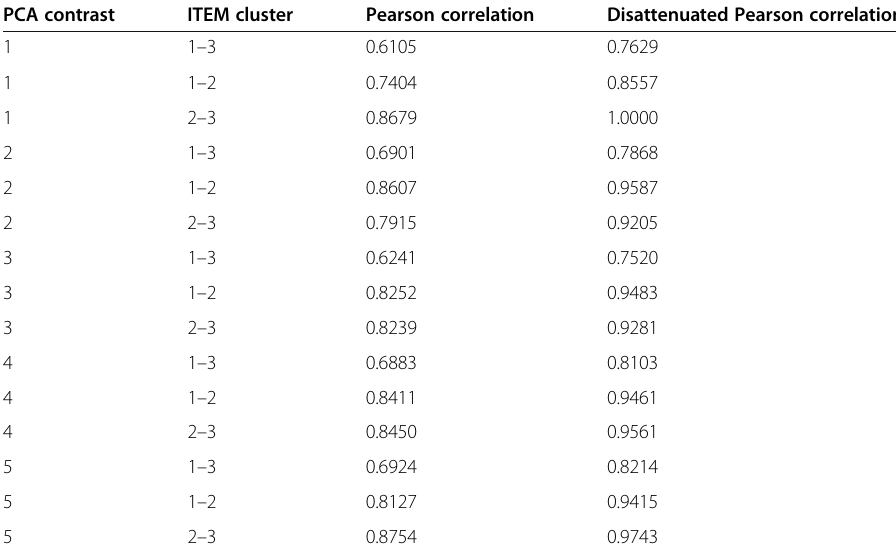
Table 4 Approximate relationships between PERSON measures PCA contrast ITEM cluster Pearson correlation Disattenuated Pearson correlation